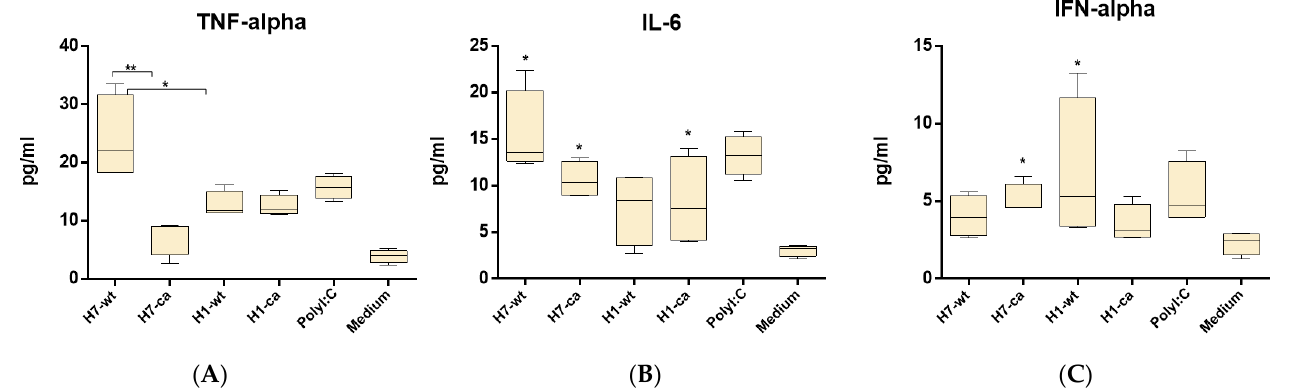
Figure 3. Early cytokine production in THP-1 cell culture, ELISA. H7-wt—A/Mallard Netherlands/12/2000(H7N3); H7-ca—A/17/Mallard Netherlands/00/95(H7N3); H1-wt—A/South Africa/3626/2013(H1N1)pdm09; H1-ca—A/17/South Africa/2013/01(H1N1)pdm09. Wells containing only RPMI medium were used as a negative control. The data of two independent experiments performed in two repetitions each are presented. ( A ) * p < 0.05, ** p < 0.01. ( B ) * p < 0.05 compared to negative-control wells. ( C ) * p < 0.05 compared to negative-control wells.